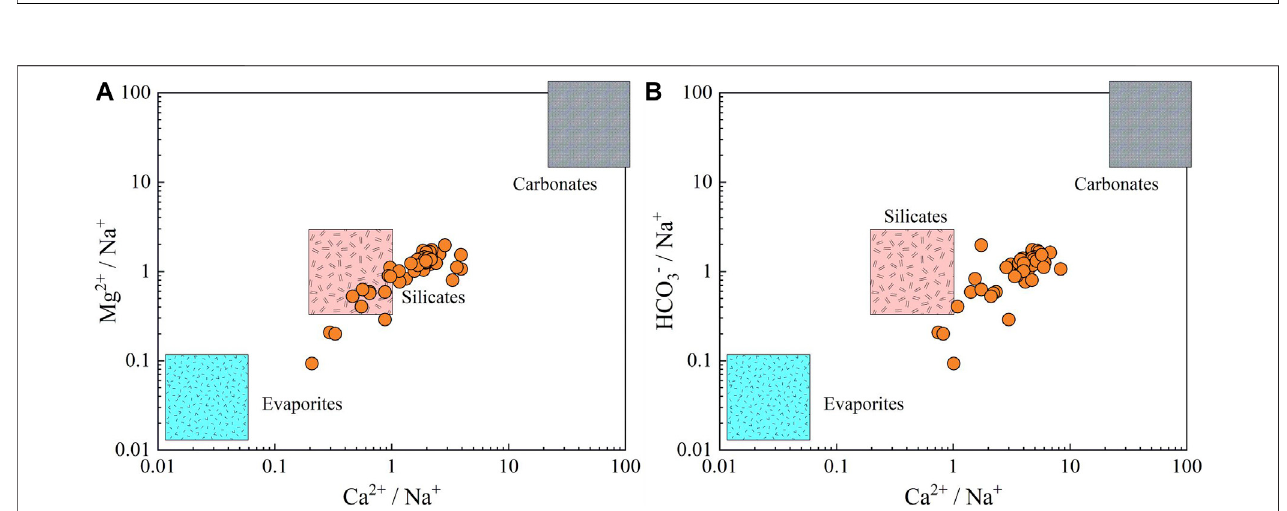
FIGURE 5 | Groundwater end-member diagrams constructed by (A) Mg 2+ /Na + versus Ca 2+ /Na + and (B) HCO 3 − /Na + versus Ca 2+ /Na + .